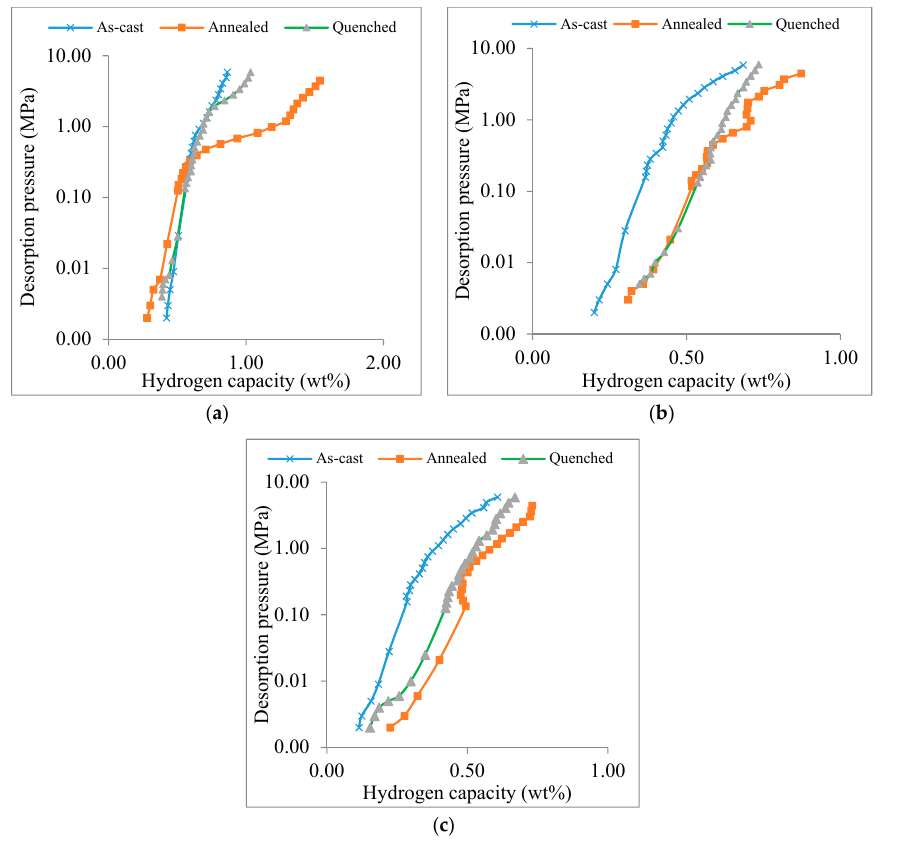
Figure 3. PCT desorption curves of the as-cast and heat-treated Ti 34 V 40 Cr 24 Fe 2 alloys at ( a ) 303, ( b ) 333, and ( c ) 363 K.